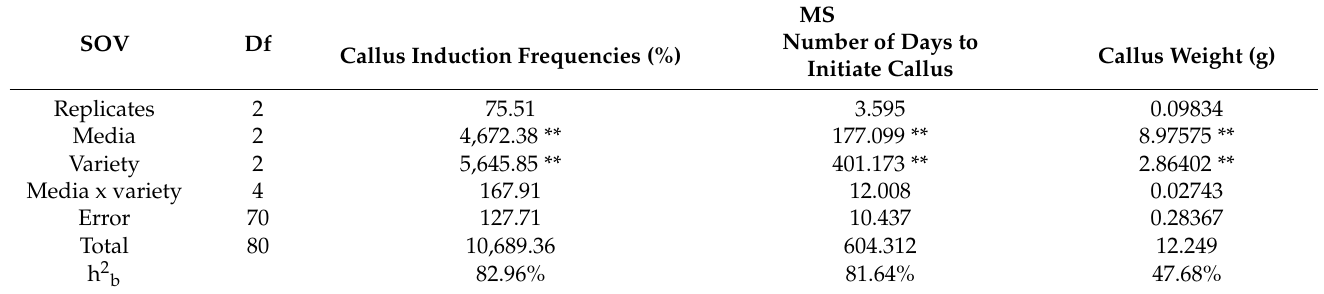
Table 1. Mean sum of squares (MS) for callus induction frequencies (%), callus weight (g) and number of days to initiate callus in Amri, Barhy and Magdoul